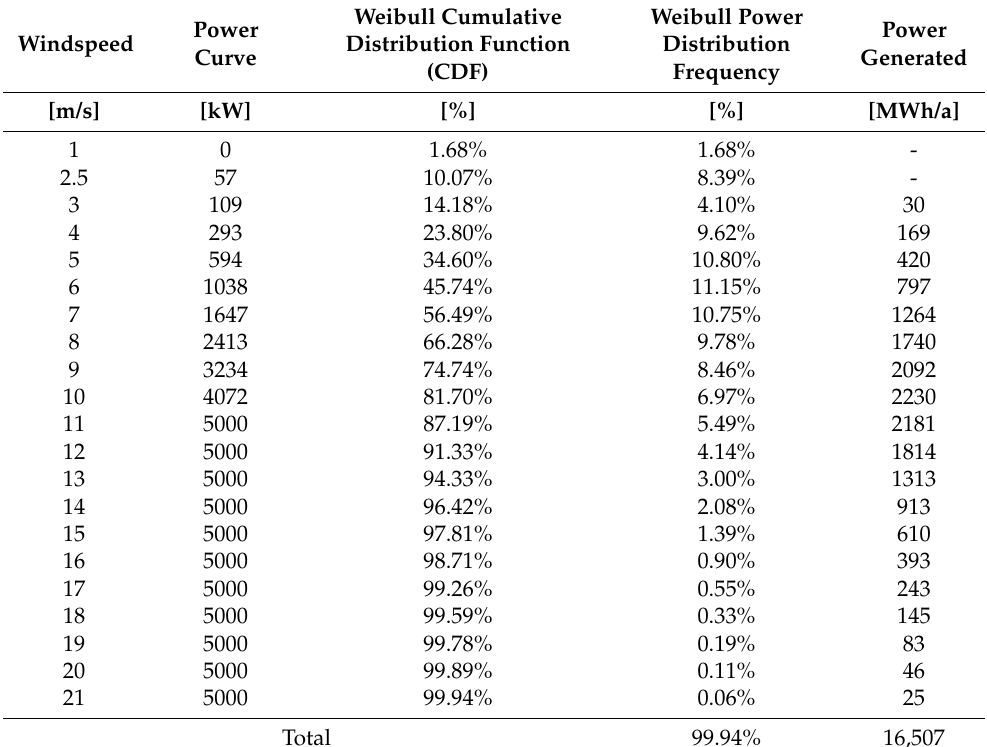
Table 2. Weibull and AEP analysis.